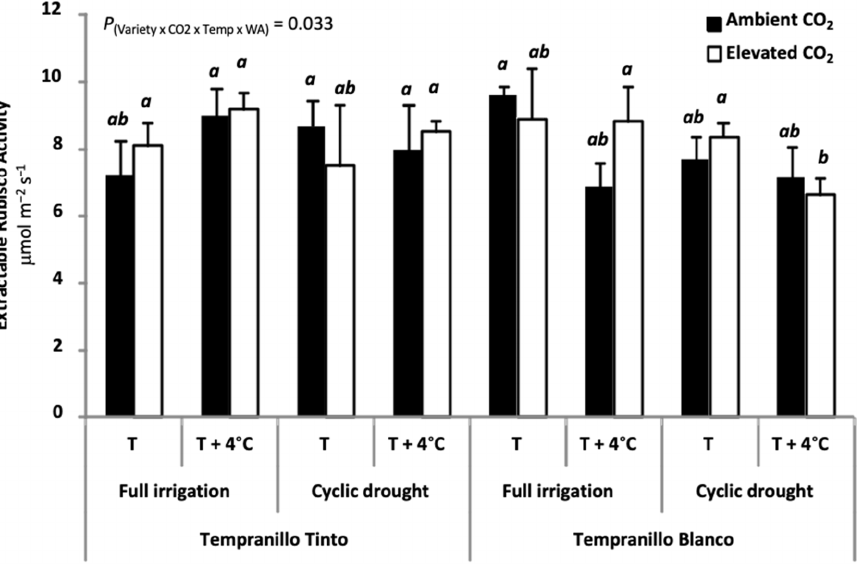
Figure 3. Extractable Rubisco activity (µmol m − 2 s − 1 ) at maturity in Tempranillo Blanco and Tinto grapevine. Treatments used for growing the plants were as follows: ambient CO 2 concentration (400 ppm) versus elevated (700 ppm), ambient temperature (T) versus ambient + 4 °C (T + 4 °C), and full irrigation versus cyclic drought. Significant differences ( p < 0.05) were based on LSD test (n = 3, mean ± SE) and are indicated by different letters. Rubisco enzyme activity data were obtained by T. Kizildeniz during her PhD thesis measuring spectrophotometrically the NADH oxidation as previously described [59].